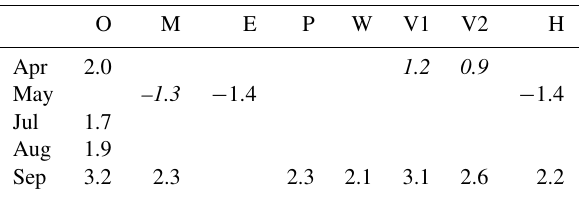
Table 7. Linear, decadal changes in monthly mean SW ↓ (Wm − 2 ) at Bergen between January 1985 and December 1999, significant at a 5% or 10% (denoted in italics) level. O M E P W V1